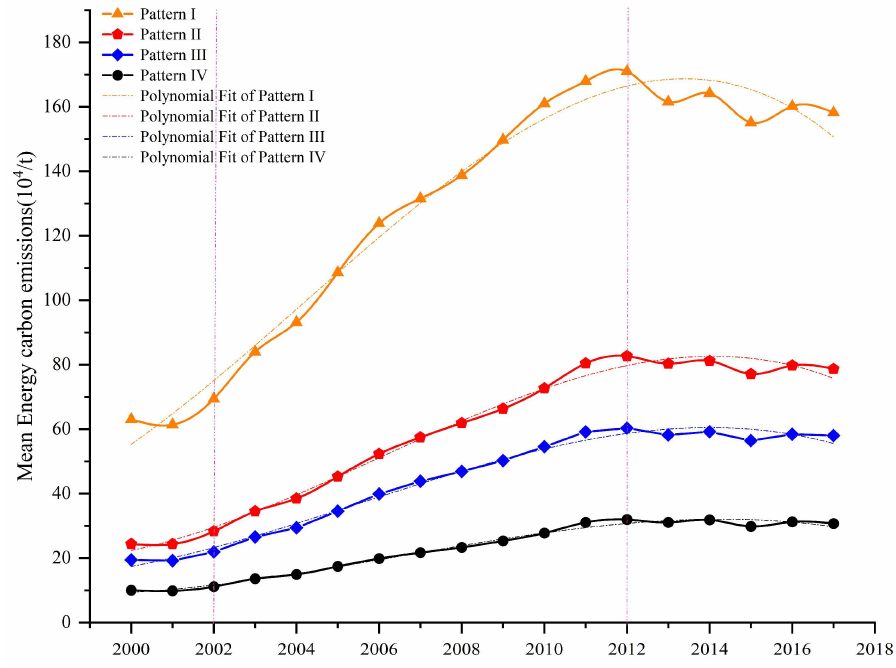
Figure 6. CO 2 emission time